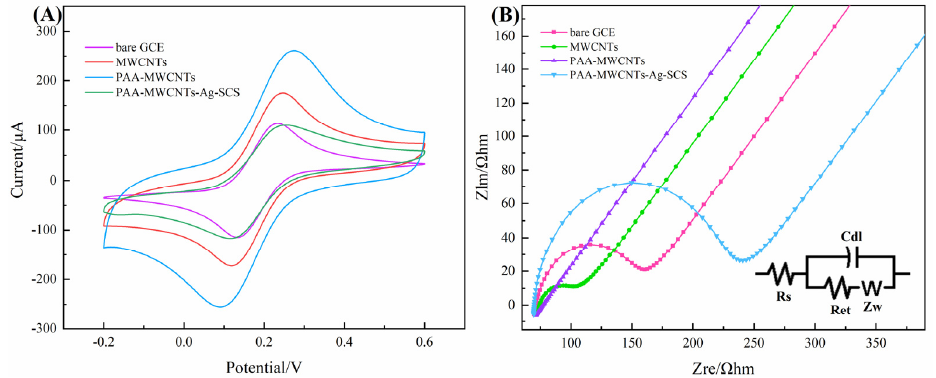
Figure 4. CV curves ( A ) and EIS curves ( B ) of the GCE, MWCNTs/GCE, PAA-MWCNTs/GCE, and PAA-MWCNTs-Ag-SCS/GCE in 0.1 M KCl containing 5 mM [Fe(CN) 6 ] 4 − /3 −